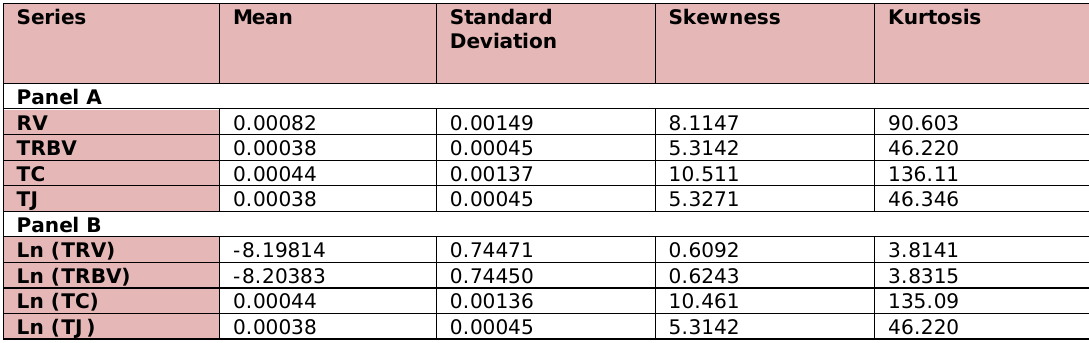
Table 2. “Descriptive statistics of threshold realized Volatility levels”. Source: Own